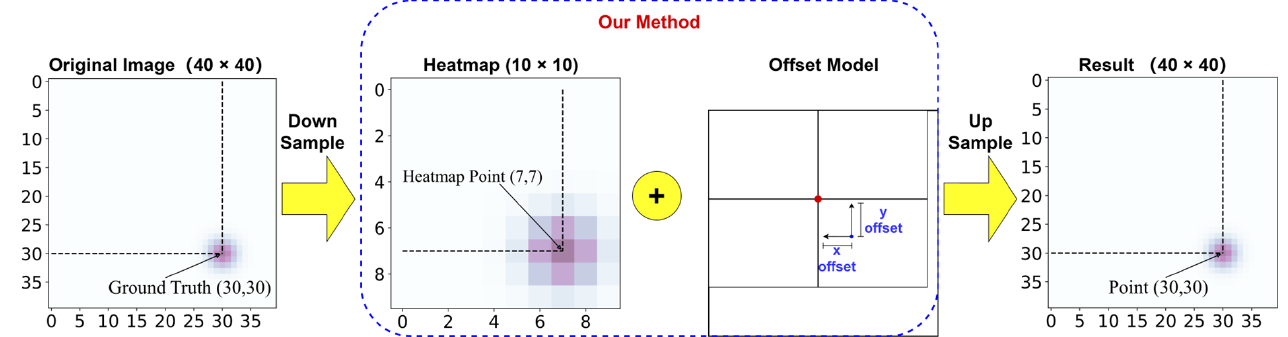
Figure 5. Schematic diagram of Gaussian Heatmap and Grid Offset Module.